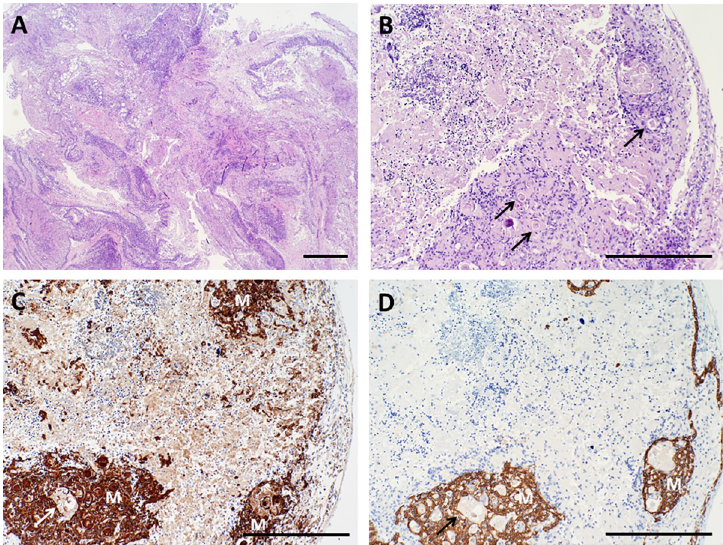
Fig 6. Architecture of cultured thymus, day 20. A, B. Hematoxylin and eosin (H&E) stain. At this time point, most thymocytes have either been lost from the tissue or they have died and their nuclei have been dissolved, making the tissue more eosinophilic (pink). Large groups of residual thymocytes are rare, although scattered cells with nuclear characteristics of thymocytes are evident. C. Pan-cytokeratin (AE1/AE3) immunoreactivity. Much of the epithelium present in formerly medullary areas (M) is condensed due to loss of medullary thymocytes, but scattered epithelial cells indicative of a residual light, lacy, three-dimensional network of thymic epithelial cells remain. D. Cytokeratin 14 (CK14) immunohistochemistry highlights former medullary areas and the subcapsular cortex. Brown color indicates a positive reaction with antibody. Arrows point to representative Hassall bodies. Bar represents 1 mm in A and 500 μ m in